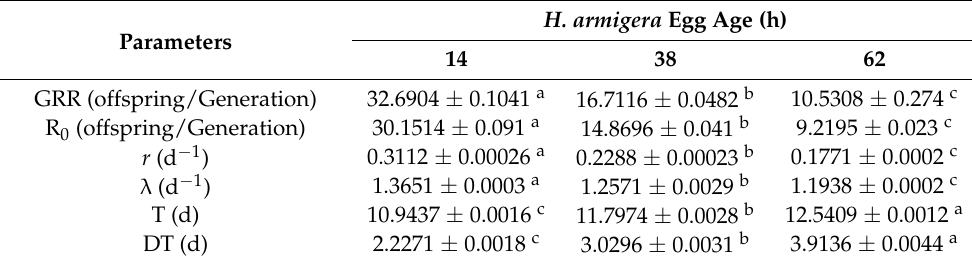
Table 3. Mean ( ± SE) values of life table parameters for T. euproctidis reared from H. armigera eggs of different